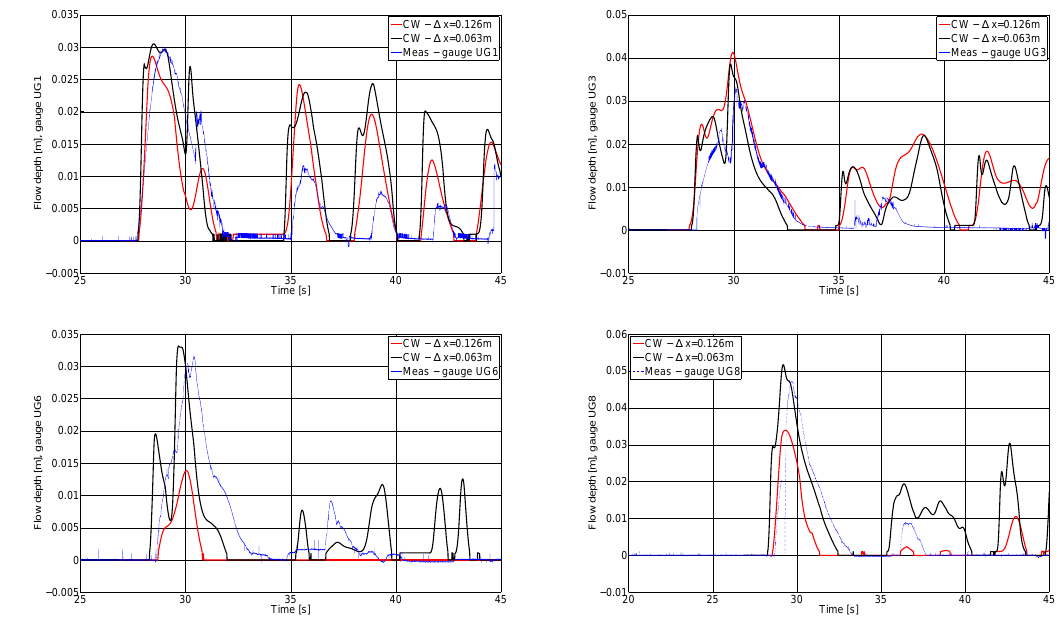
Figure 7. Simulated near-shore wave evolution and inundation compared to measured signals at Geiranger using Coulwave.